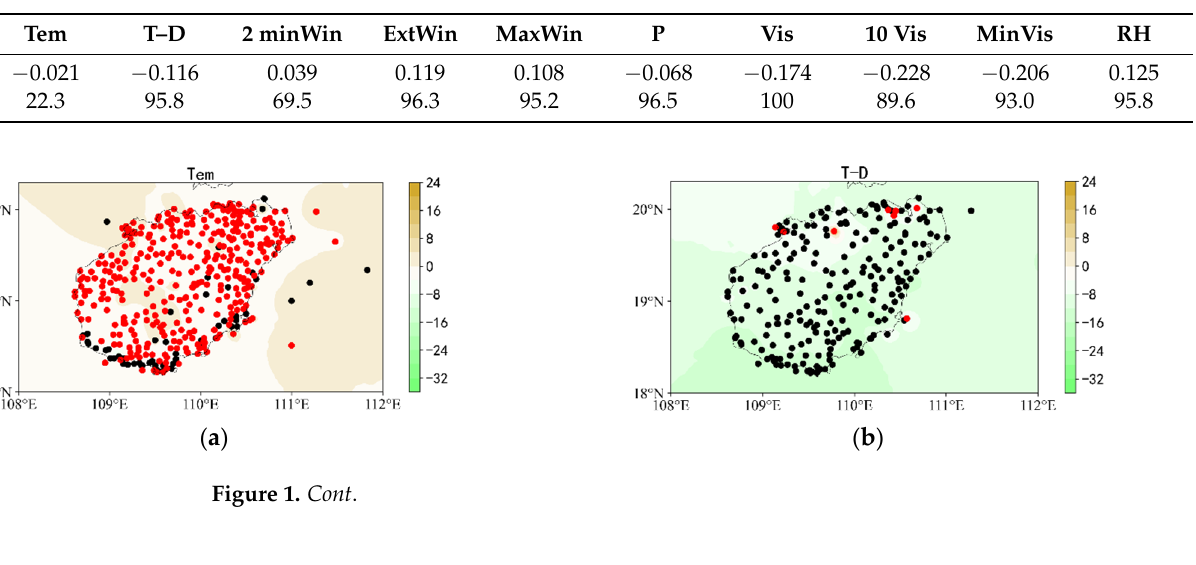
Table 1. Correlation coefficients (CC) and percentages (P) of stations that passed the significance test for each weather component and hourly precipitation in Hainan Province, from September 2020 to August 2021.